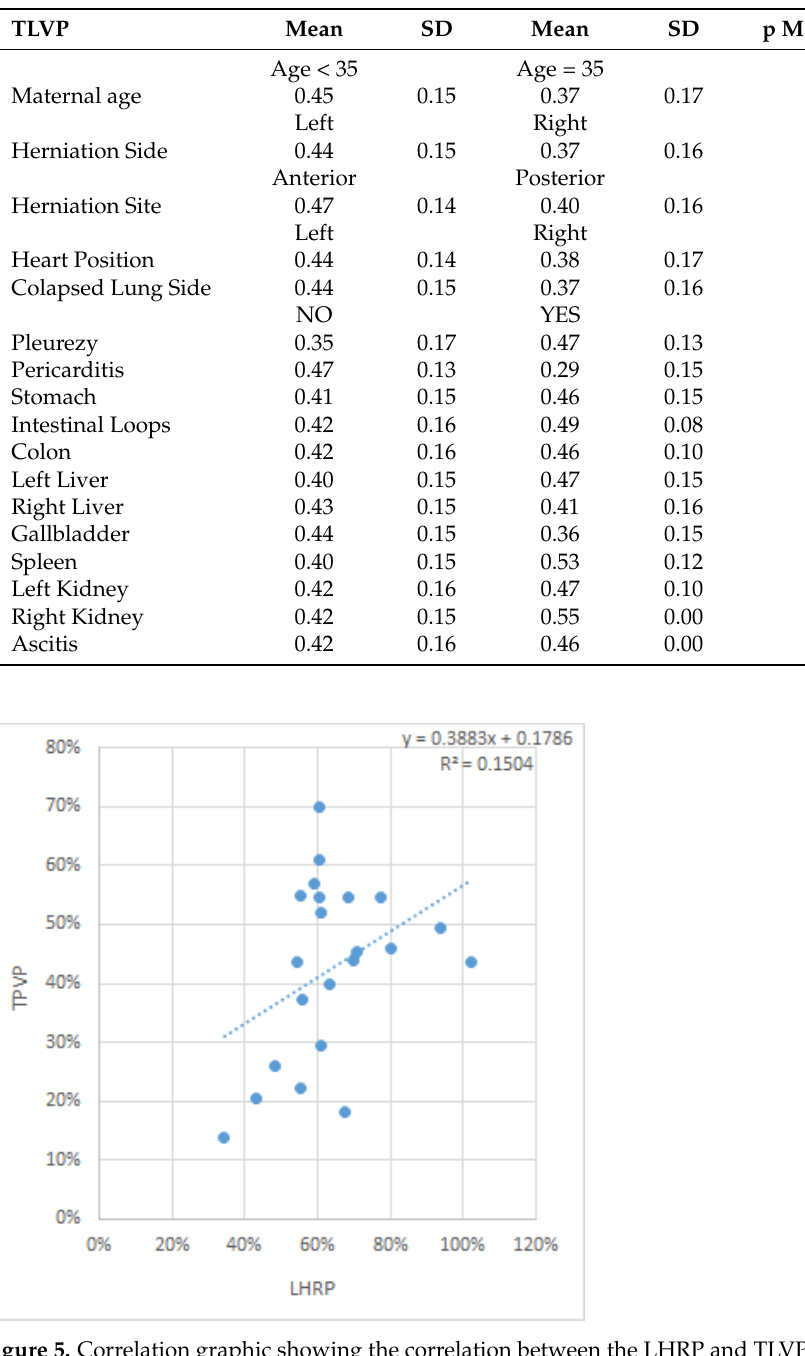
Figure 5. Correlation graphic showing the correlation between the LHRP and TLVP. It is interesting to note that two of the three cases with the most extreme values (mean- ing a difference between the LHRP and the TLVP bigger than 45%), came from patients presenting a right-sided CDH; only one of the three presented a left-sided herniation. In two cases (9%), although both the LHR and the pulmonary volume showed lower than normal values, the LHR actually overestimated the volume loss to as much as